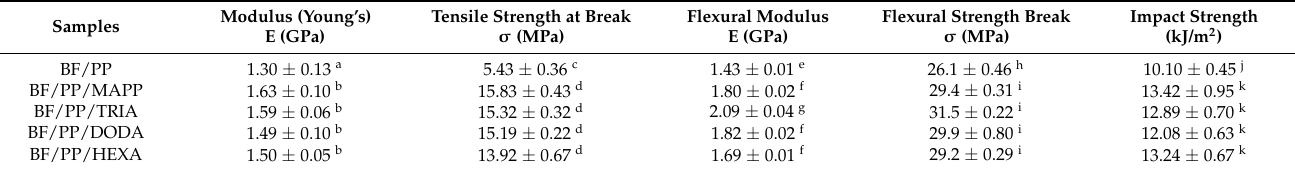
Table 2. Summary results of the mechanical properties of BF/PP composites without and with CA.